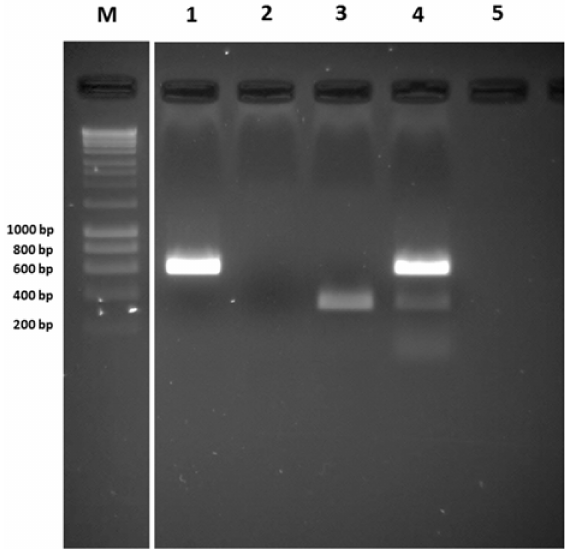
Figure 4. Simultaneous detection of mycoviruses in an A. fumigatus isolate (A80) which was infected naturally by a mixture of AfuCV and AfuTmV-1. In lanes 1, 2 and 3, amplicons were produced using AfuCV, AfuPV-1 or AfuTmV-1 primers, respectively. In lane 4, RNA isolated from the mixedly infected A80 isolate was used as template and multiplex RT-PCR was performed using all three primer pairs. Lane 5 showed the negative template control. Hyperladder-I was used as a marker to estimate the size of the amplicon (Lane